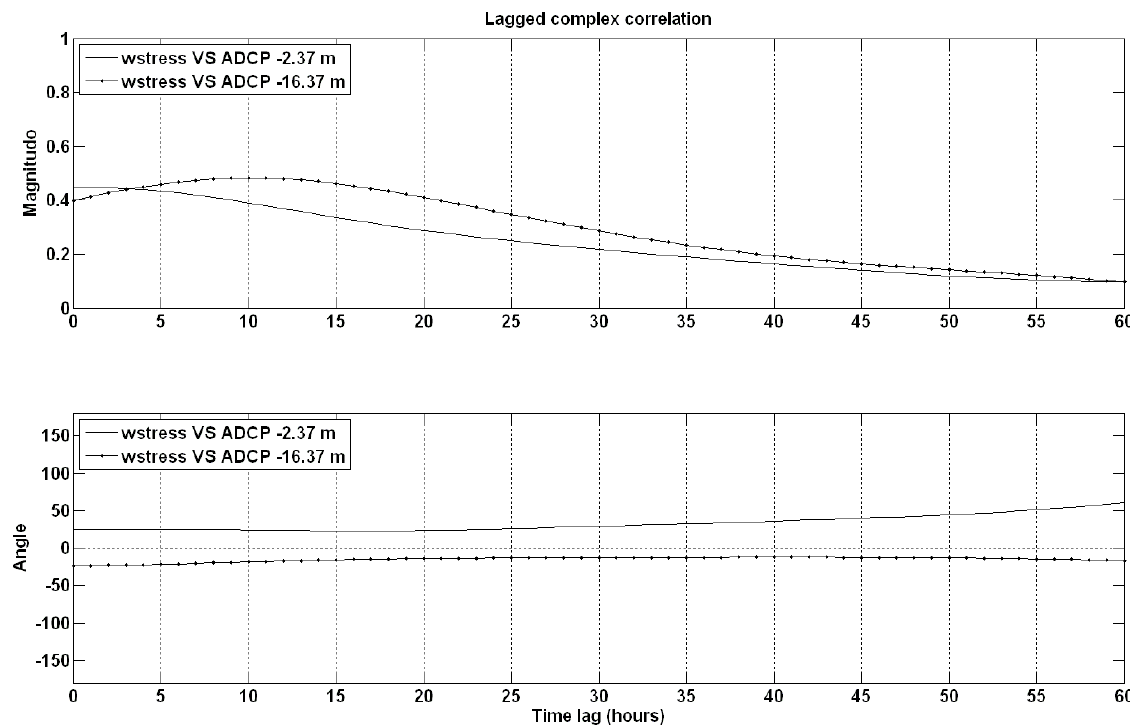
Fig. 12. Lagged complex (vector) cross-correlation between wind stress and low-passed ADCP subsurface currents. The solid line refers to the subsurface ( − 2.37m) level, while the dash-dotted line refers to the bottom ( − 16.37m) level. Veering angles for the same levels are depicted in the lower panel. Units are hours for the time lag on the x-axis, degrees for the y-axis in the veering angle